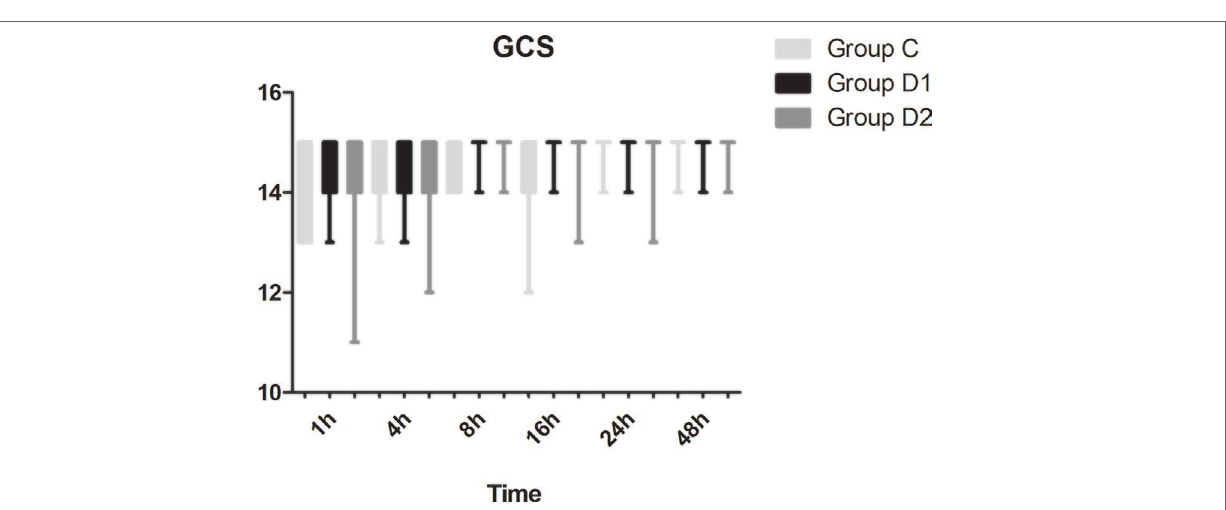
FIGURE 8 | Comparison of the Glasgow Coma Scale (GCS) scores among the three groups.